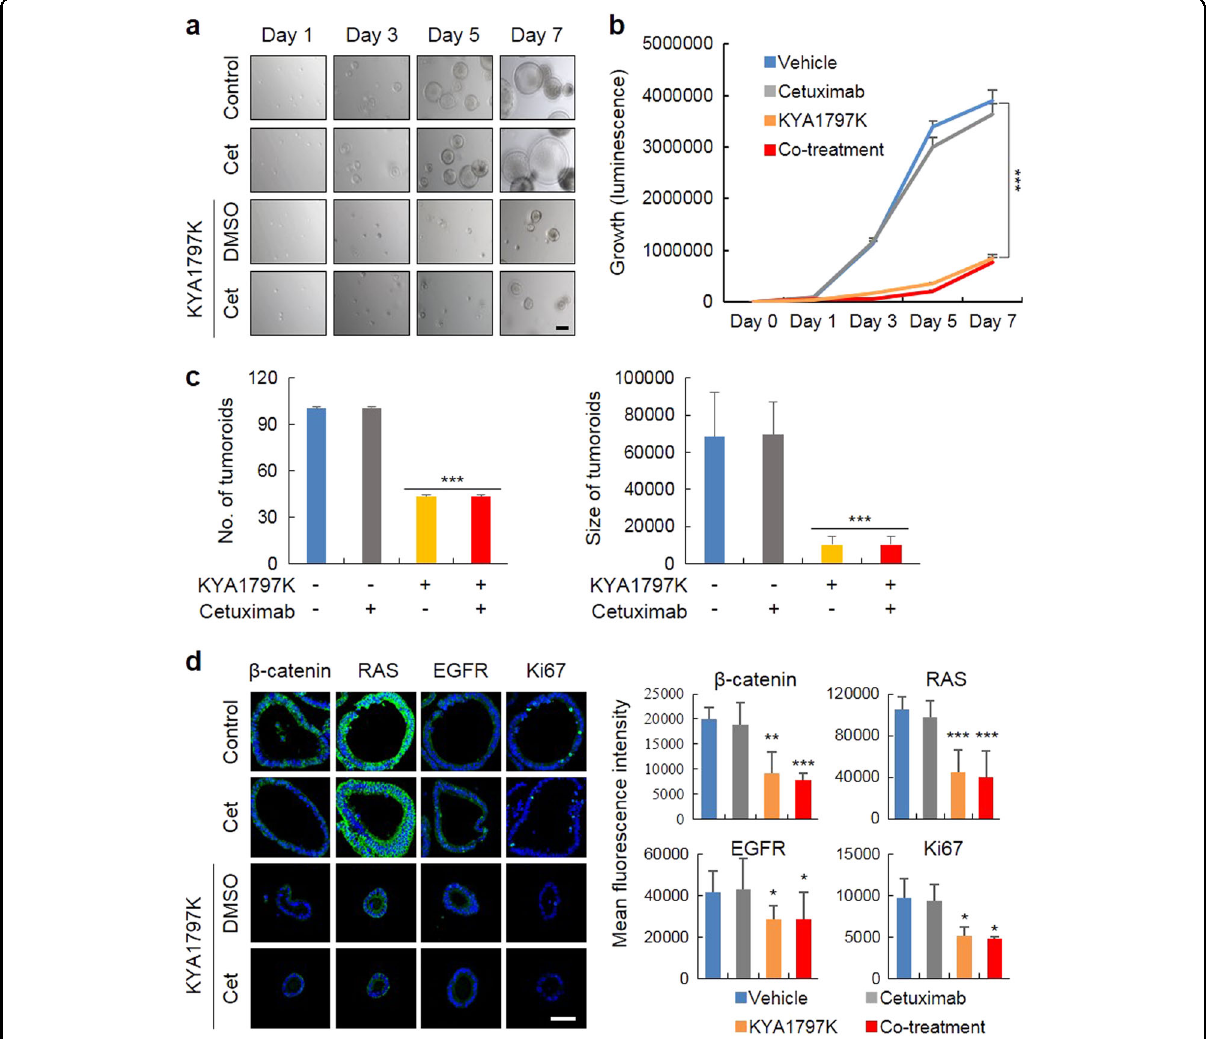
Fig. 5 The effectiveness of KYA1797K on the formation and growth of tumor organoids from the small intestine of Apc Min/ + /Kras G12D LA2 mice. The tumor organoids from the small intestine of Apc Min/ + /Kras G12D LA2 mice were cultured as described in the materials and methods section. The tumor organoids were cultured and treated under the indicated conditions for 7 days. a , b The images of the tumor organoids were visualized (a, scale bar, 200 µm), and the growth of the tumor organoids was measured by a cell titer assay ( b ). c The numbers (left) and sizes (right) of the tumor organoids were quanti fi ed. d Immunocytochemical (ICC) analysis of β -catenin, pan-RAS, EGFR, and Ki67 in the tumor organoids treated under the indicated conditions for 7 days. The tumor organoids were immobilized, immunostained with each antibody, and counterstained with DAPI ( d , left panel). Scale bar, 50 µm. The levels of these proteins were measured by the mean fl uorescence intensity ( d , right panel). The data are presented as the mean ± SD ( n = 3). Two-sided Student ’ s t- test, * P <0.05, ** P <0.005, and *** P